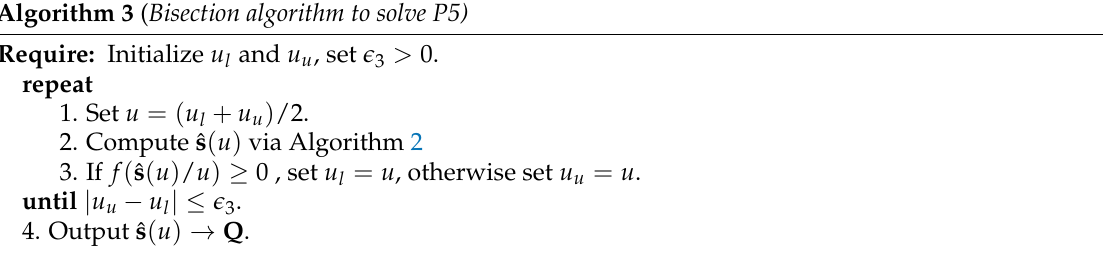
Algorithm 3 ( Bisection algorithm to solve P5)